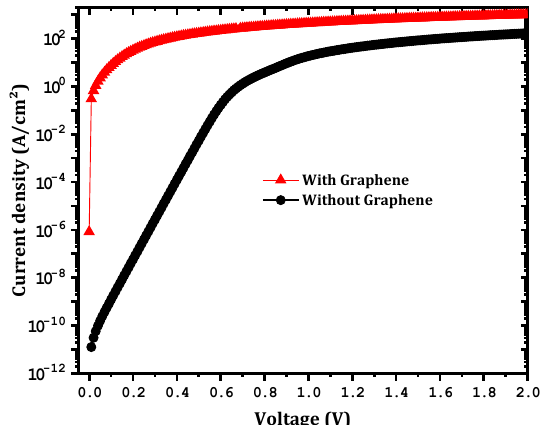
Figure 3. The effect of the insertion of a graphene layer on the forward current.